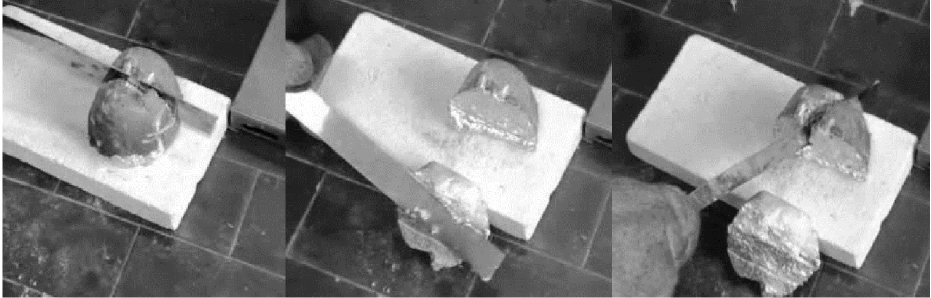
Figure 4. Billet of a semi-solid metal cut with an ordinary